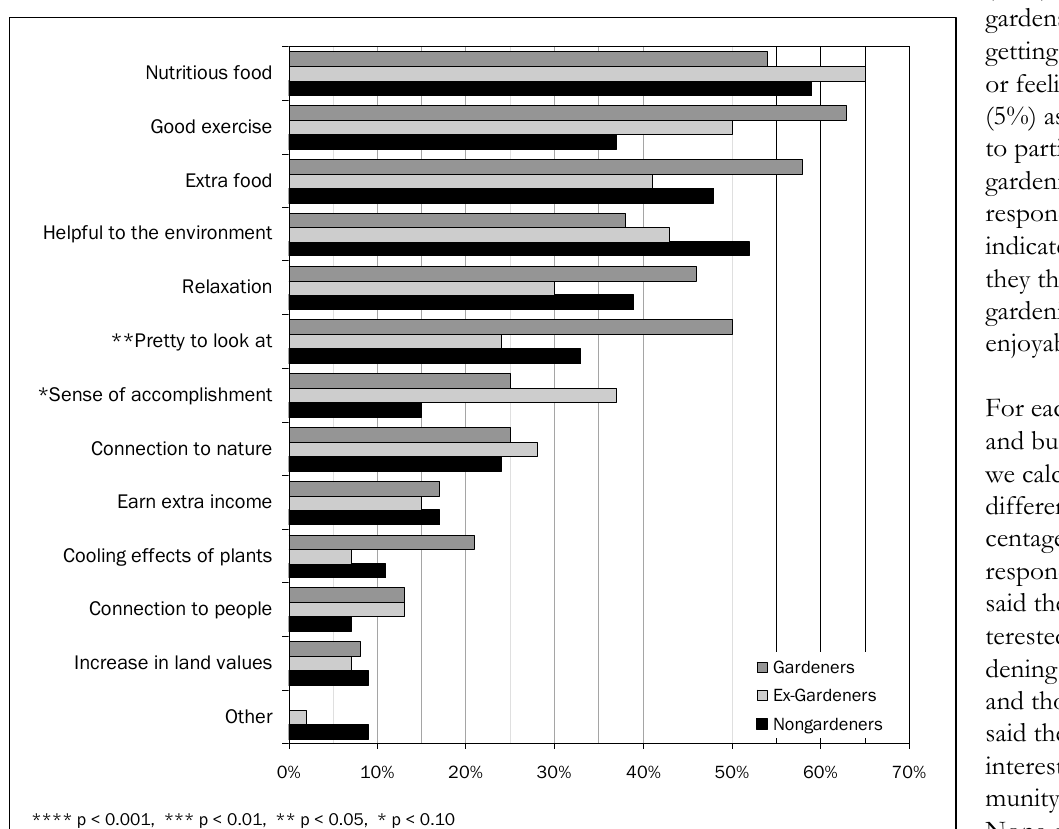
Figure 1. Percent of Respondents by Gardening Status Who Identified the Item as an Important Benefit of Gardening